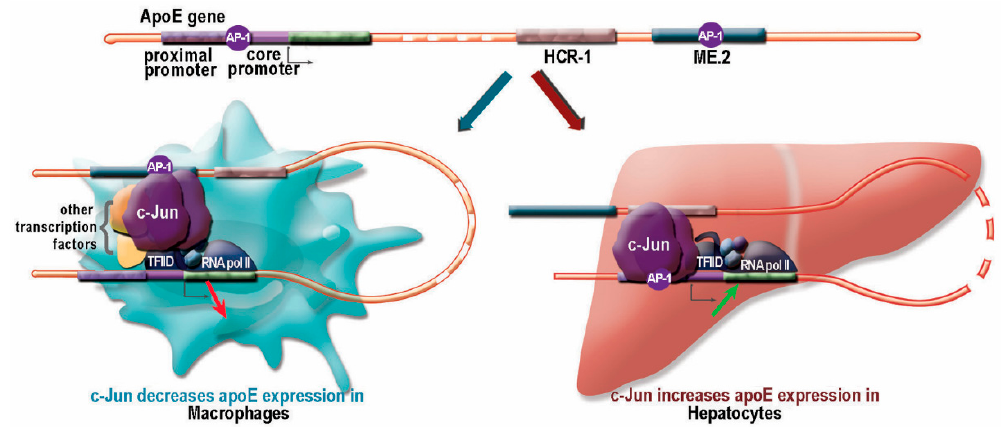
Figure 4. Schematic representation of cell-specific effects of c-Jun on apoE gene expression. In macrophages, c-Jun binding to the apoE core promoter downregulated apoE expression, in conjunction with other transcription factors. ME.2 distal regulatory element was brought into the proximity of the apoE promoter, and the functional AP-1 binding site on ME.2 additionally potentiated c-Jun repression of apoE (left side). In hepatocytes, the HCR-1 distal regulatory element interacted with the apoE promoter, but apoE expression was upregulated by c-Jun in a classical manner through binding to a canonical binding site located at − 94/ − 84 in the apoE proximal promoter, (right side). AP-1 sites are illustrated as purple circles.